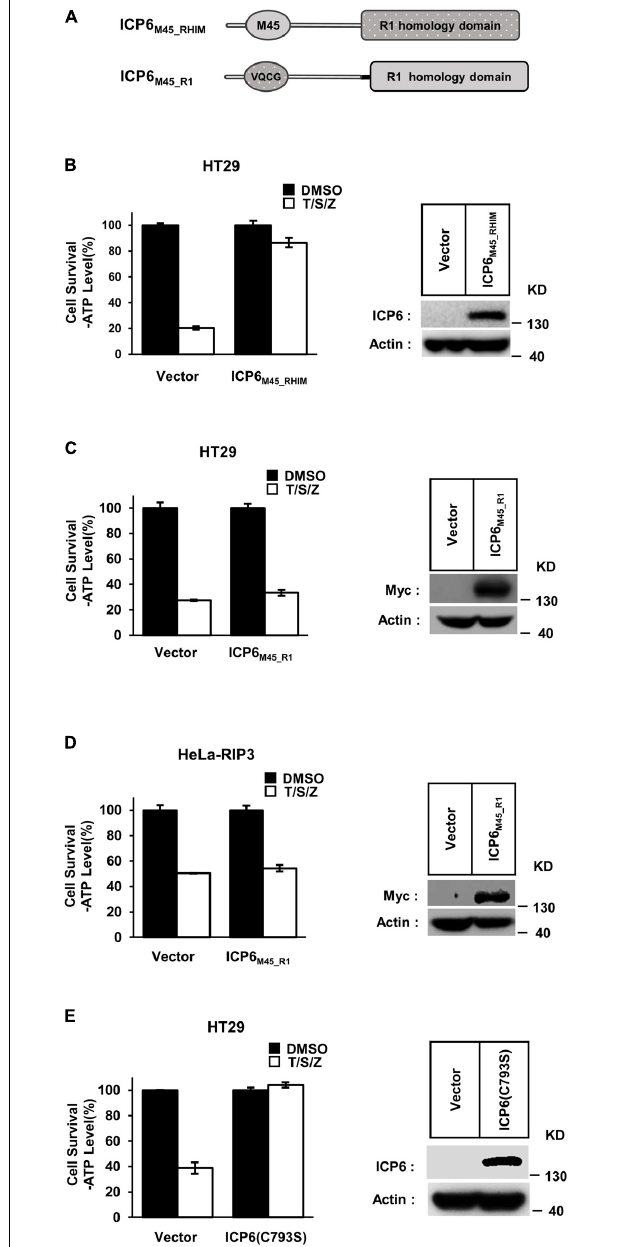
FIGURE 2 | The R1 domain of ICP6 is unique in inhibiting necroptosis. (A) Schematic representation of chimaeric ICP6 containing M45 RHIM and R1-homology domain. (B) The chimaeric ICP6 containing M45 RHIM has no effect on the inhibition of necroptosis. Necroptosis was induced by T/S/Z for 10 h. Then the cells were lysed and subjected to western blotting analysis using the indicated antibodies. (C,D) The R1 homology domain is important to ICP6 function. The HT29 (C) and Hela-RIP3 (D) cells with indicated lentivirus infection were treated with T/S/Z for 10 h. Cell viability was determined by measuring ATP levels (left) . The data are represented as the mean ± SD of duplicate wells. The expression level of ICP6 M45_R1 was measured by western blot analysis (right) . (E) The ICP6 (C793S) has no effect on the inhibition of necroptosis. Necroptosis was induced by T/S/Z for 10 h. Then the cells were lysed and subjected to western blotting analysis using the indicated